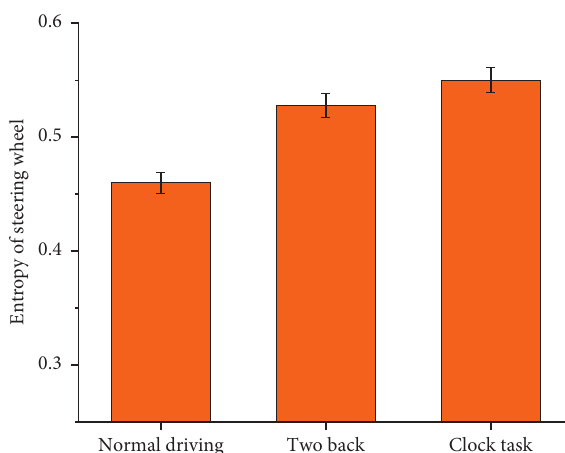
Figure 17: Main effect of the driving tasks on the